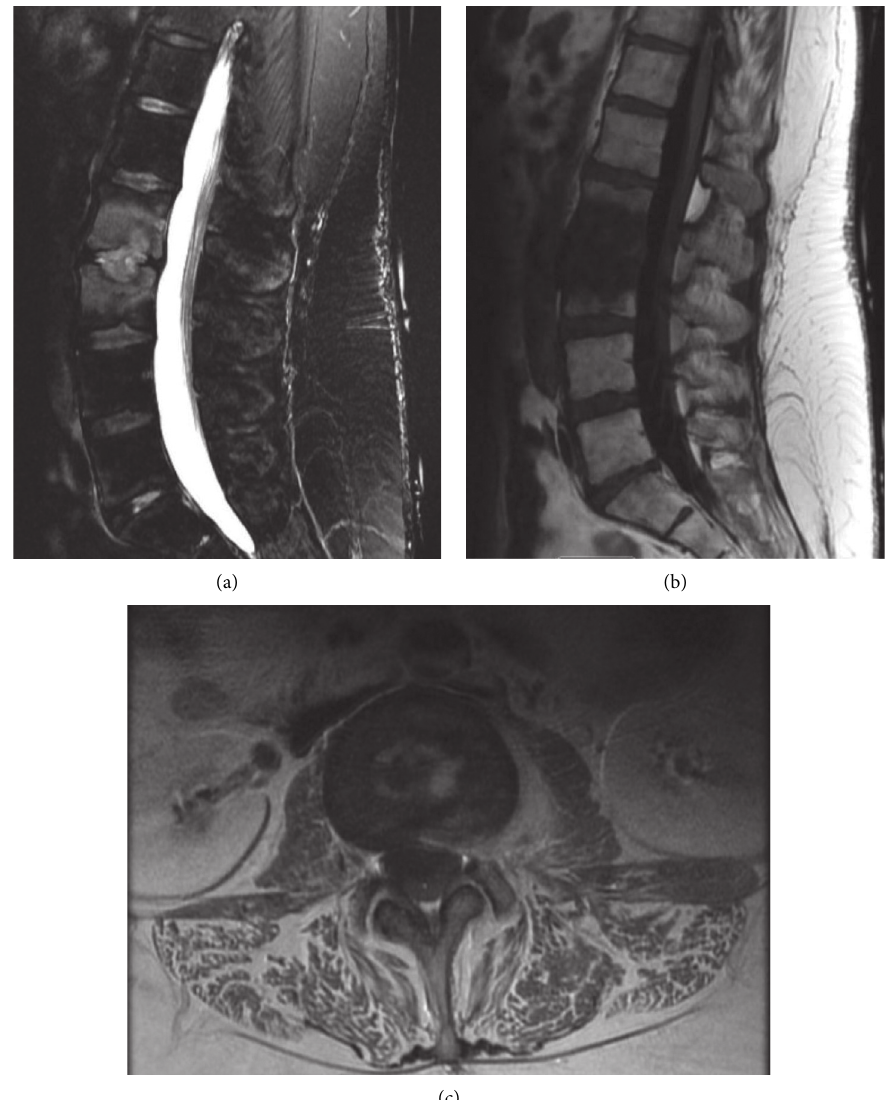
Figure 1: Sagittal T2-weighted (a), T1-weighted (b), and axial T1-weighted postcontrast (c) images demonstrating signal abnormality within the L2 and L3 vertebral bodies adjacent to the intervertebral disk space, consistent with osteomyelitis and discitis, with an extension to the left psoas muscle and epidural